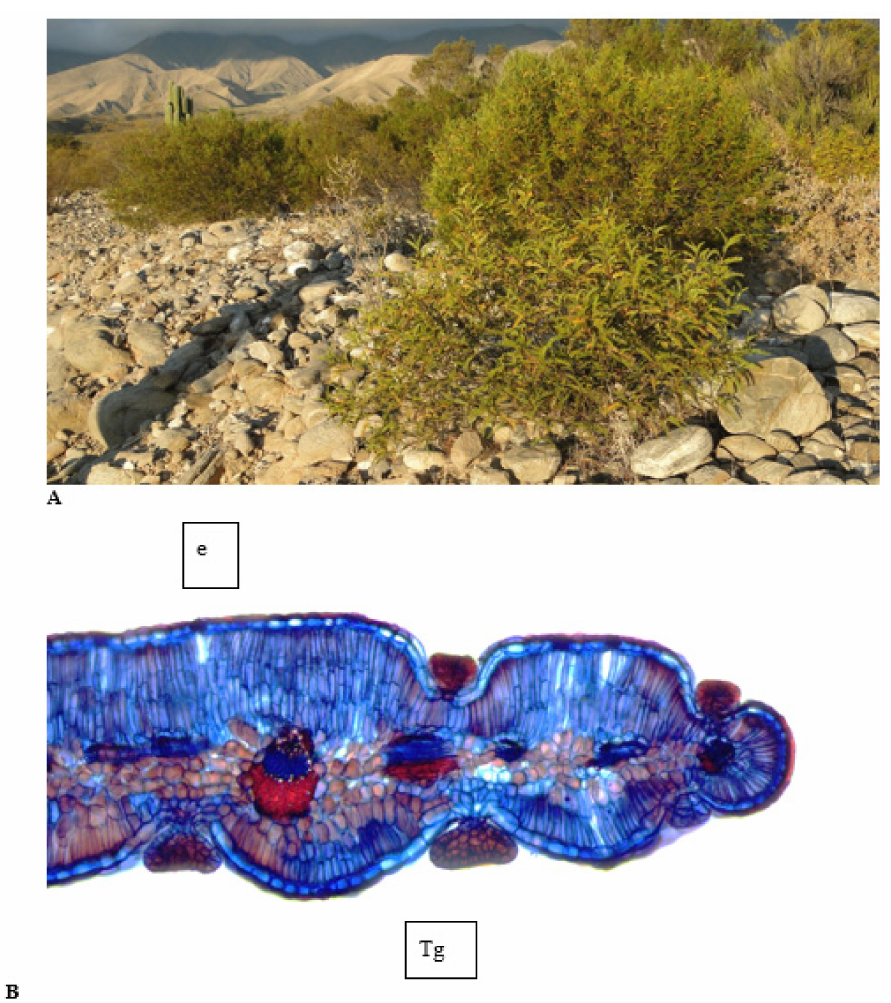
Figure 1. ( A ) Jarillal in the Monte region, ( B ) Zuccagnia punctata. Leaflet anatomy. Adaxial epidermis. Abaxial epidermis. Tg, capitate glandular trichome; e,